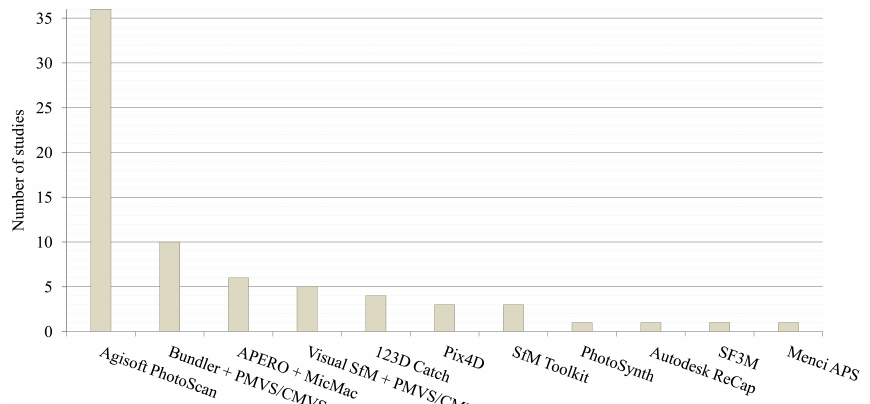
Figure 3. Variety of SfM photogrammetry tools used in the 65 reviewed